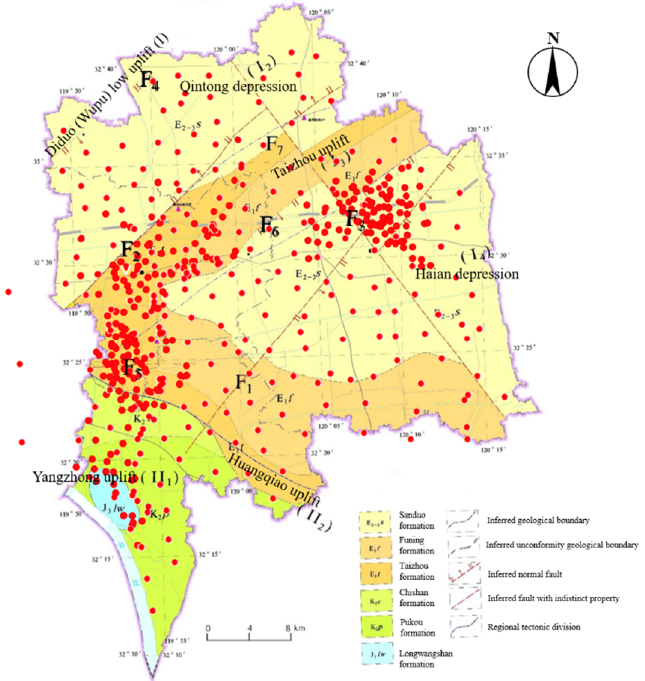
Figure 5. Stratigraphic distribution map and structural zoning map and distribution map of boreholes in study area. Table 1. Detailed stratigraphic information.